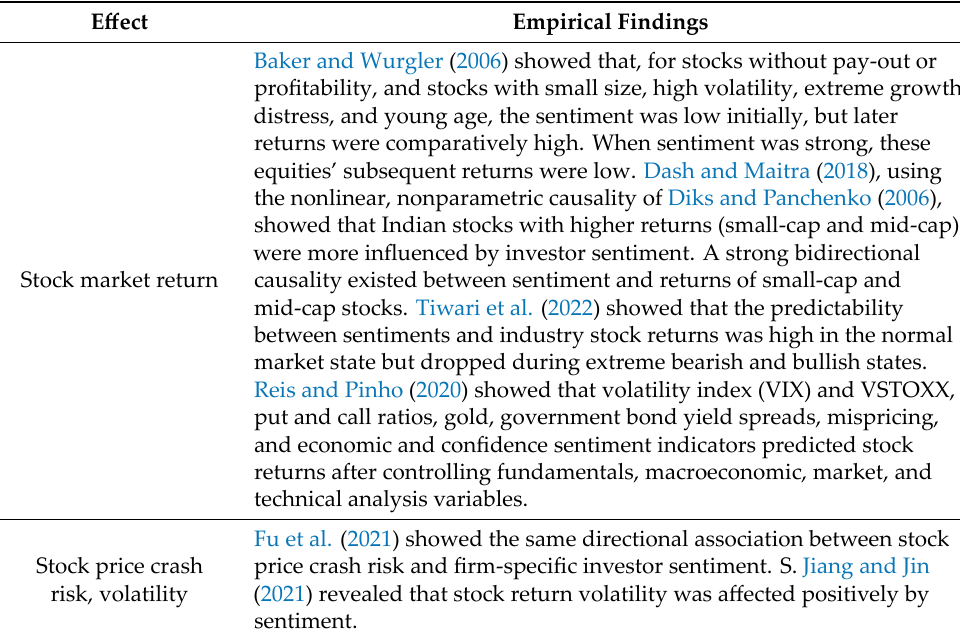
Table 2. Investor sentiment and stock market